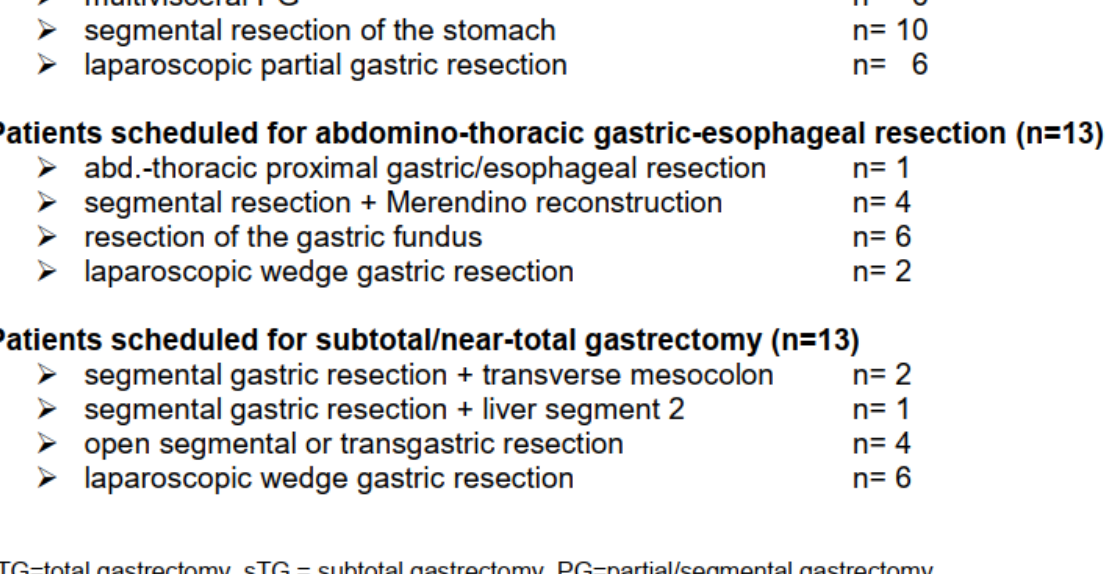
Figure 4. Comparison of scheduled surgery prior to imatinib vs. surgical procedure performed after neoadjuvant ther- apy.